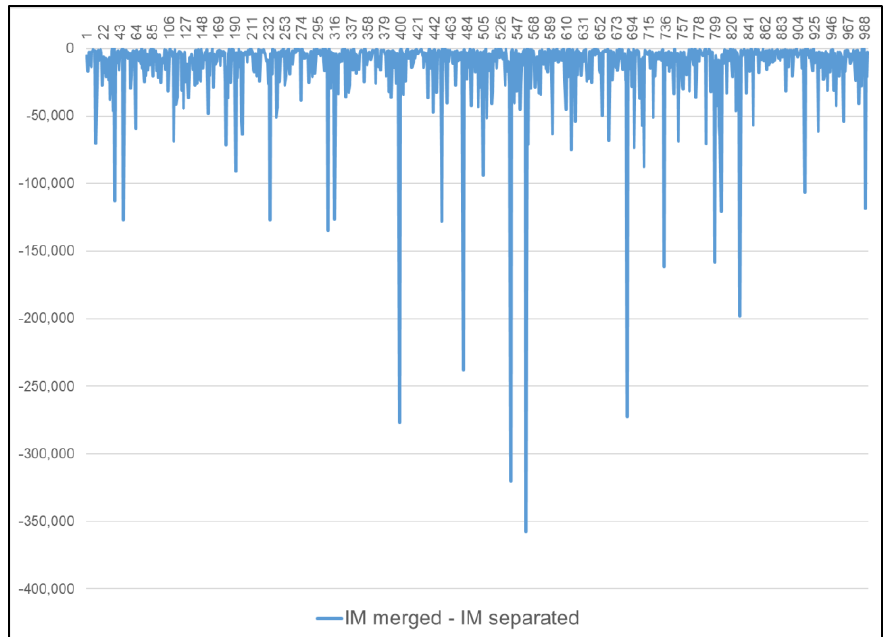
Figure 8. Difference between the margin values of the separated and the merged markets.